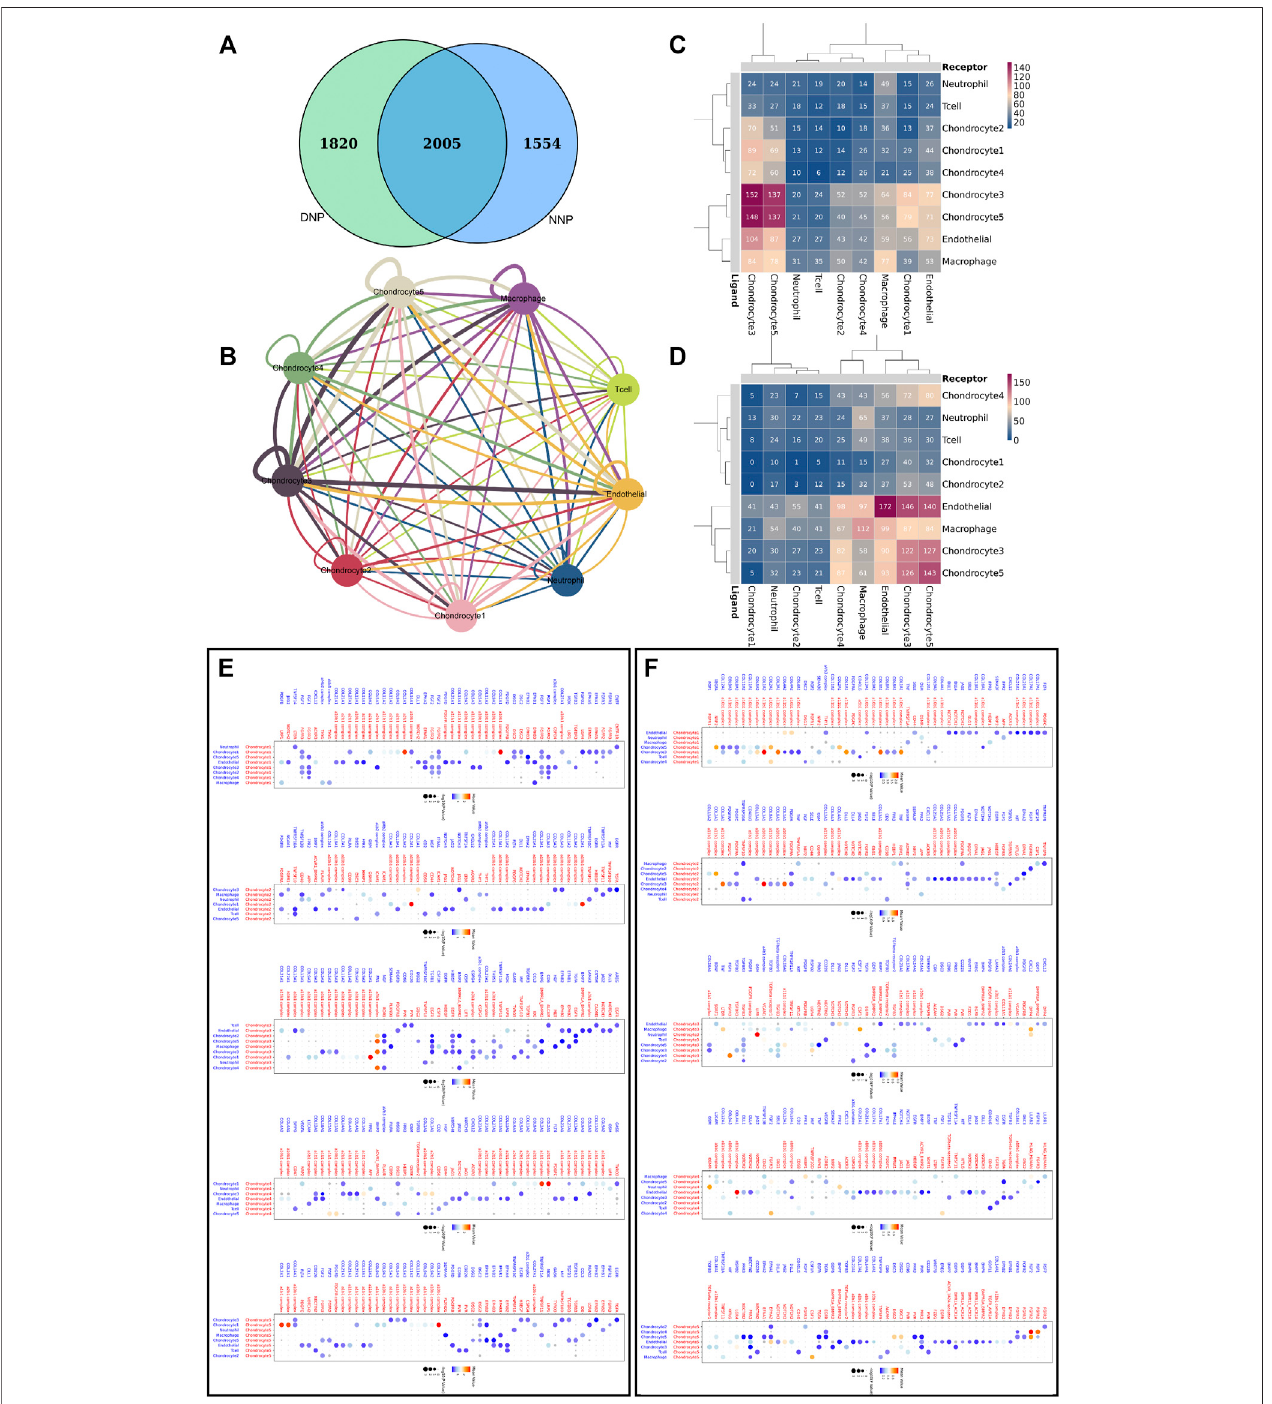
FIGURE 7 | Cell – cell communication network of CellPhoneDB in the nucleus pulposus cells. (A) Venn diagram of genes related to cell communication, and NNP is related to DNP cell cellphone relations number in our data. (B) Interaction network constructed by CellPhoneDB. Thicker lines indicate more interaction with other types of cells. (C) Heatmap showing the number of potential ligand – receptor pairs among the predicted cell types in NNP. (D) Heatmap showing the number of potential ligand – receptorpairsamongthepredictedcelltypesinDNP. (E) NNPcellligand – receptorpairsdetectedwithCellPhoneDBareshowninabubbleplot. (F) DNPcell ligand – receptor pairs detected with CellPhoneDB are shown in a bubble plot.